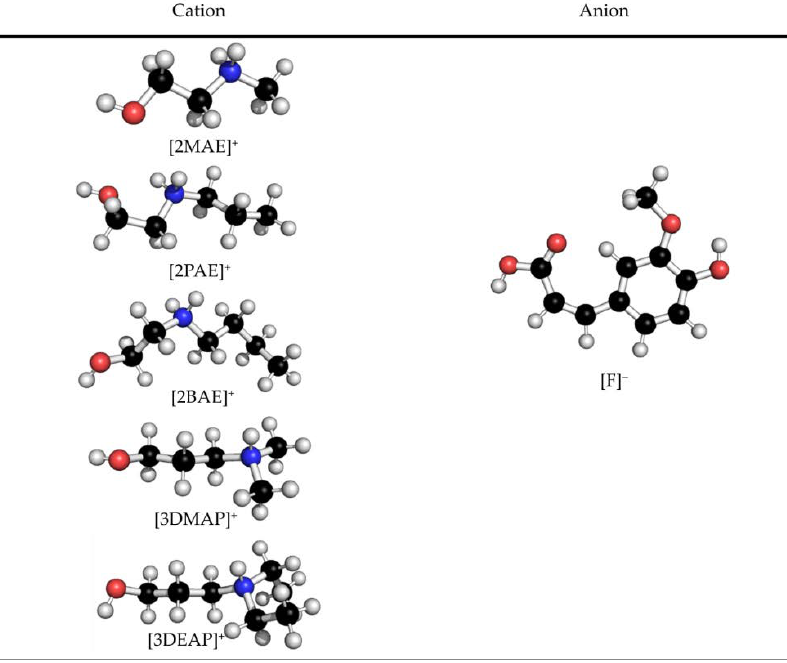
Figure 2. Cation and anion structure of the synthesized PILs.